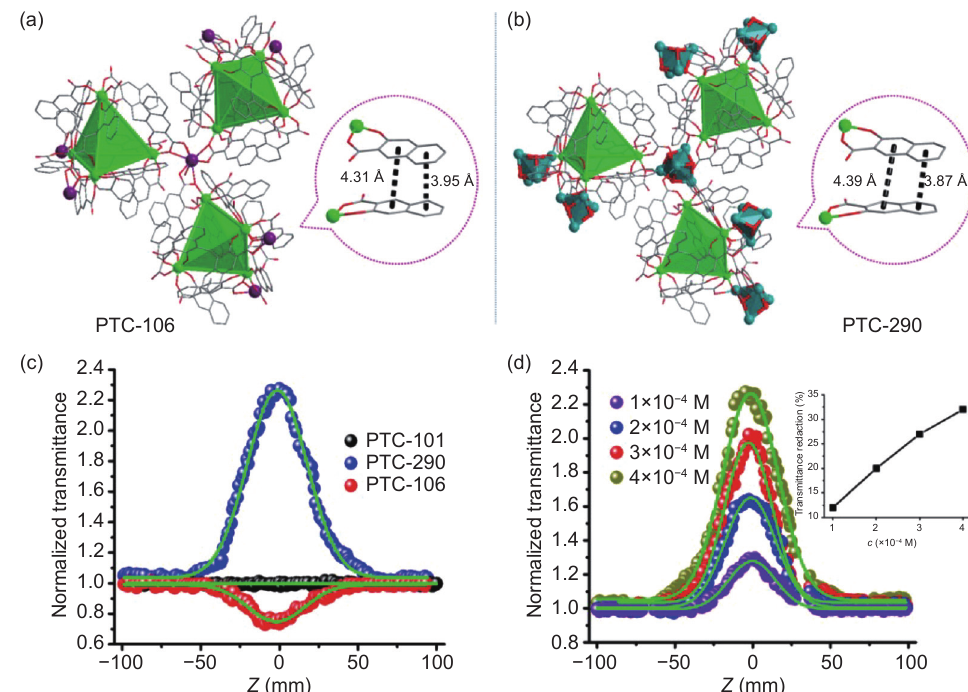
Figure 3 (a) and (b) The π···π interactions in isoreticular PTC-106 and PTC-290. (c) OA Z-scan (points) and theoretical fit (solid lines) curves of PTC-101, PTC-106, and PTC-290 at 532 nm and (d) PTC-290 with different effect of concentration on the third-order NLO performance. The NLO responses of PTC-290 are explicitly dependent on its